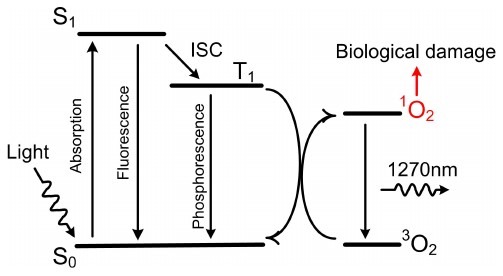
Fig. 1. Simpli¯ed Jablonski energy-level diagram for Type-II ( 1 O 2 mediated) PDT. During photosensitization, 1 O 2 is widely regarded as the major cytotoxic reactive oxygen species that resulted in biological